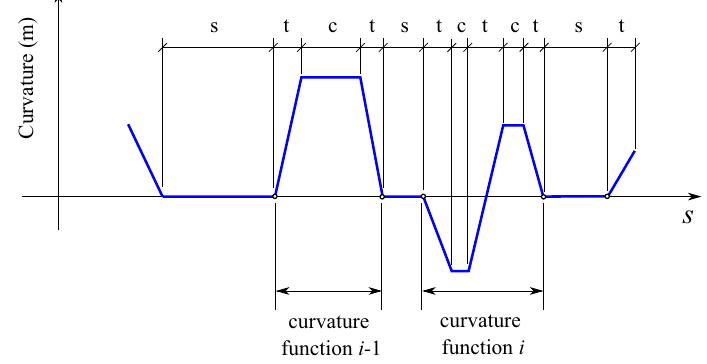
Figure 9. Design horizontal curvature of a railway